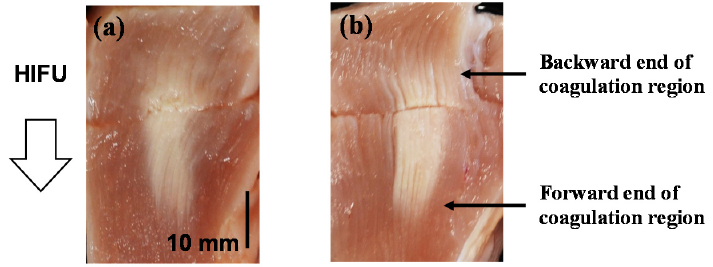
Figure 11. High-speed pulse inversion images of cavitation clouds by transmitting diverging waves in chicken breast tissues during HIFU exposure [34]. The applied HIFU sequence was the same as used for the experiments shown in Figure 7 except for the focal plane shift. The total HIFU exposure time was 16.5 s. ( a ) the focal plane of the trigger pulses was not shifted; ( b ) the focal plane of the trigger pulses was shifted 10 mm forward from that of the heating bursts. In both cases, the focal plane of the heating bursts was the same as the geometric focal plane corresponding to a depth of 120 mm.